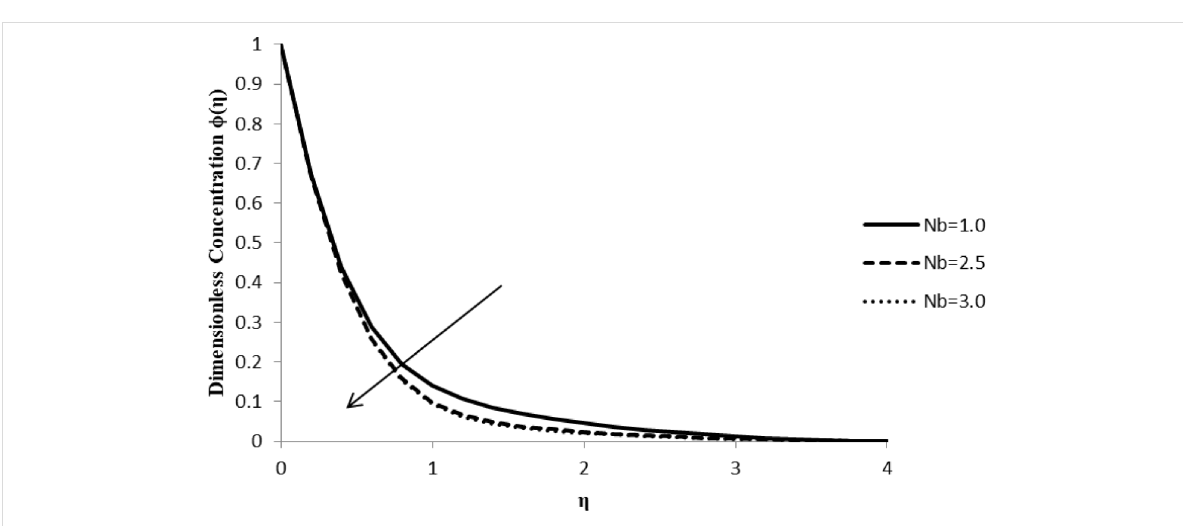
Figure 9: Influence of the Brownian motion parameter Nb on the concentration distribution ϕ ( η ) when n = 2.0, ξ = 1.0, M = Q = 0.0, Pr = 2.0, Nt = 0.5, Le = 5.0, and F w =